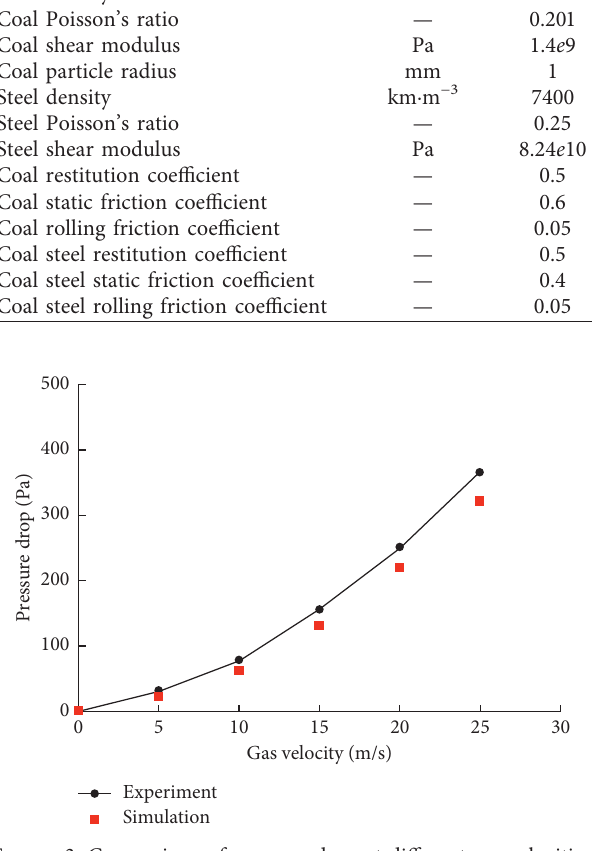
Figure 3: Comparison of pressure drop at different gas velocities ( d � 1.44mm and D �